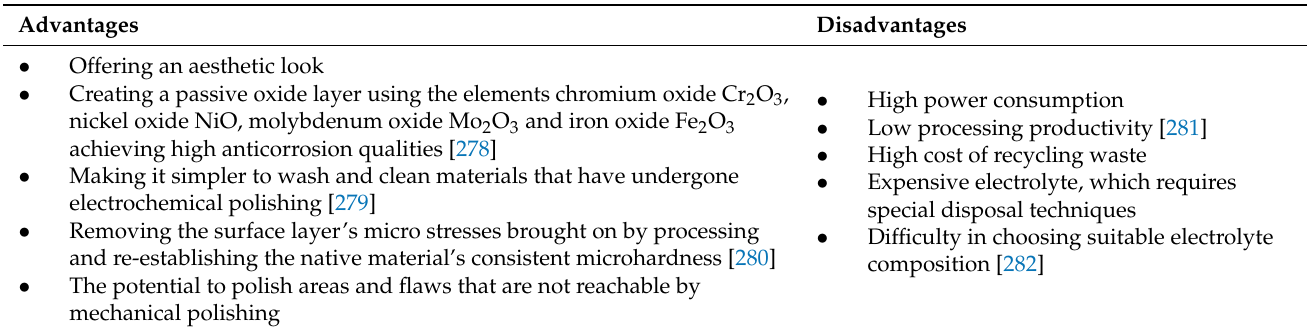
Table 21. Advantages and disadvantages of electrochemical polishing.